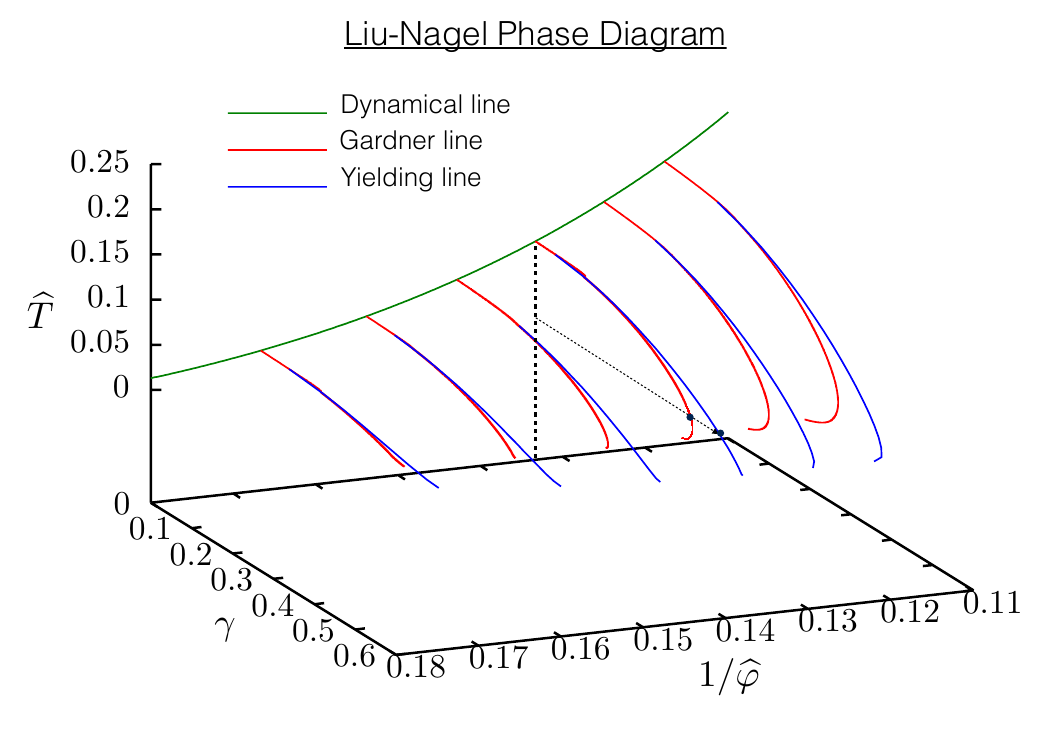
Figure 1: The mean field theory Liu-Nagel phase